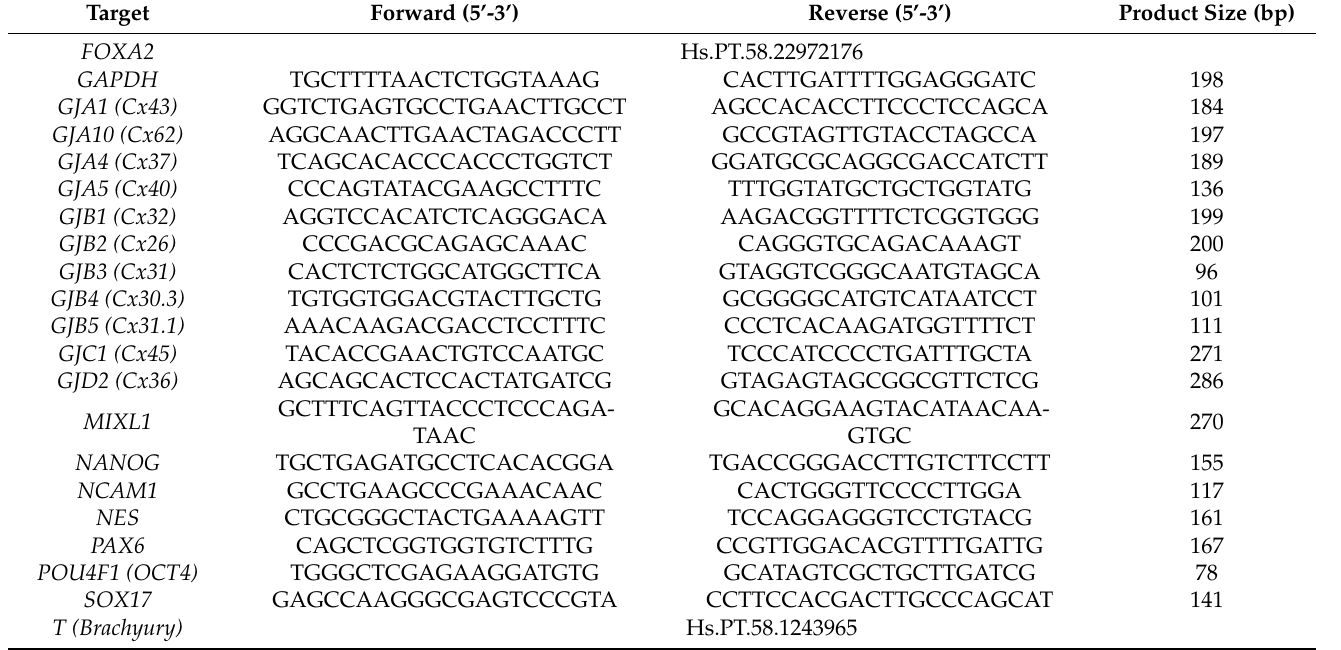
Table 3. Primer sets used in qPCR